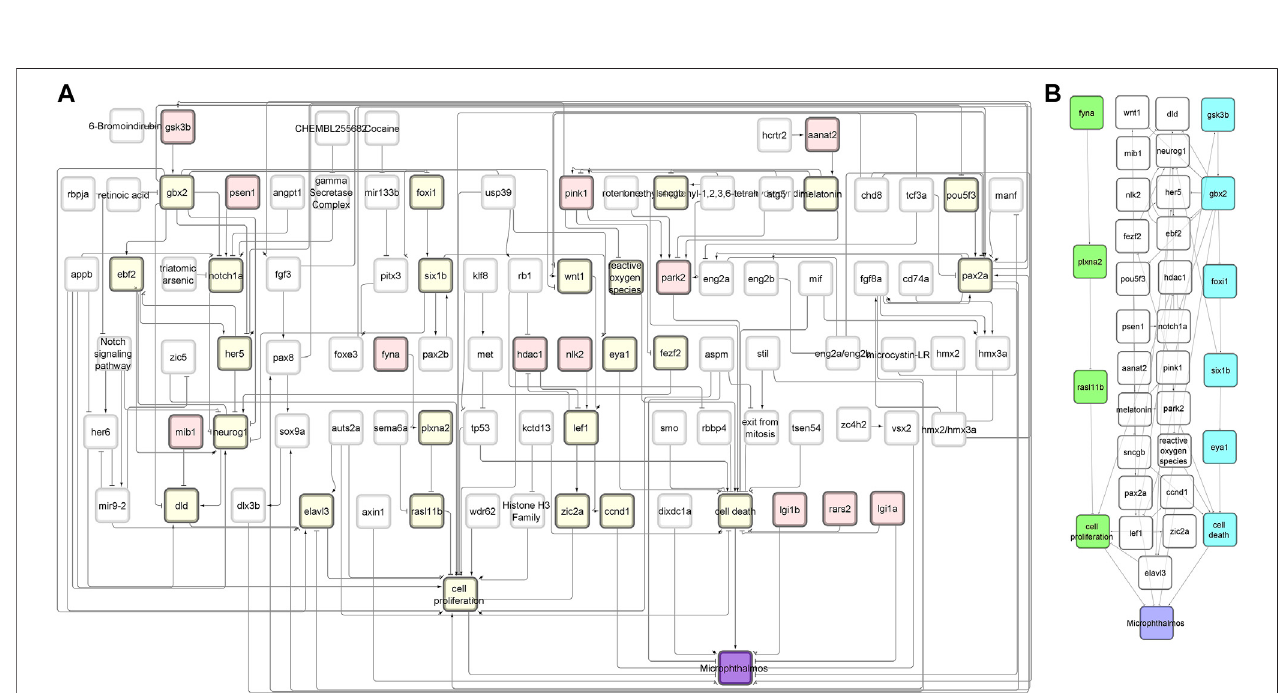
FIGURE 2 | NTOX network. (A) The reduced NTOX network (125 nodes, 212 connections) where the start nodes are enzymes (red) and the fi nal node is microphthalmos (purple). All other nodes that are part of the candidate AOPs are marked in yellow. (B) The subnetwork of the candidate AOPs that end with microphthalmos. The two candidate AOPs that were further developed into AOPs are marked in green (AOP 399) and blue (AOP 410).